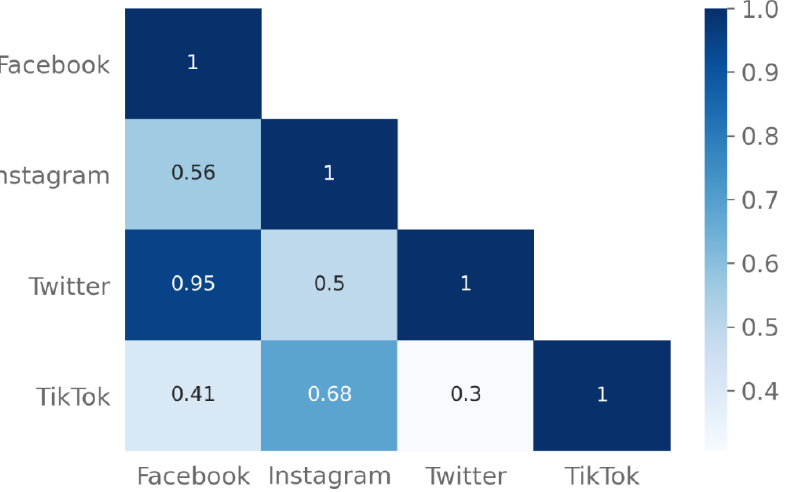
Figure 2. The matrix of cosine similarity scores of anti-vaccine comments’ distributions between social media platforms.